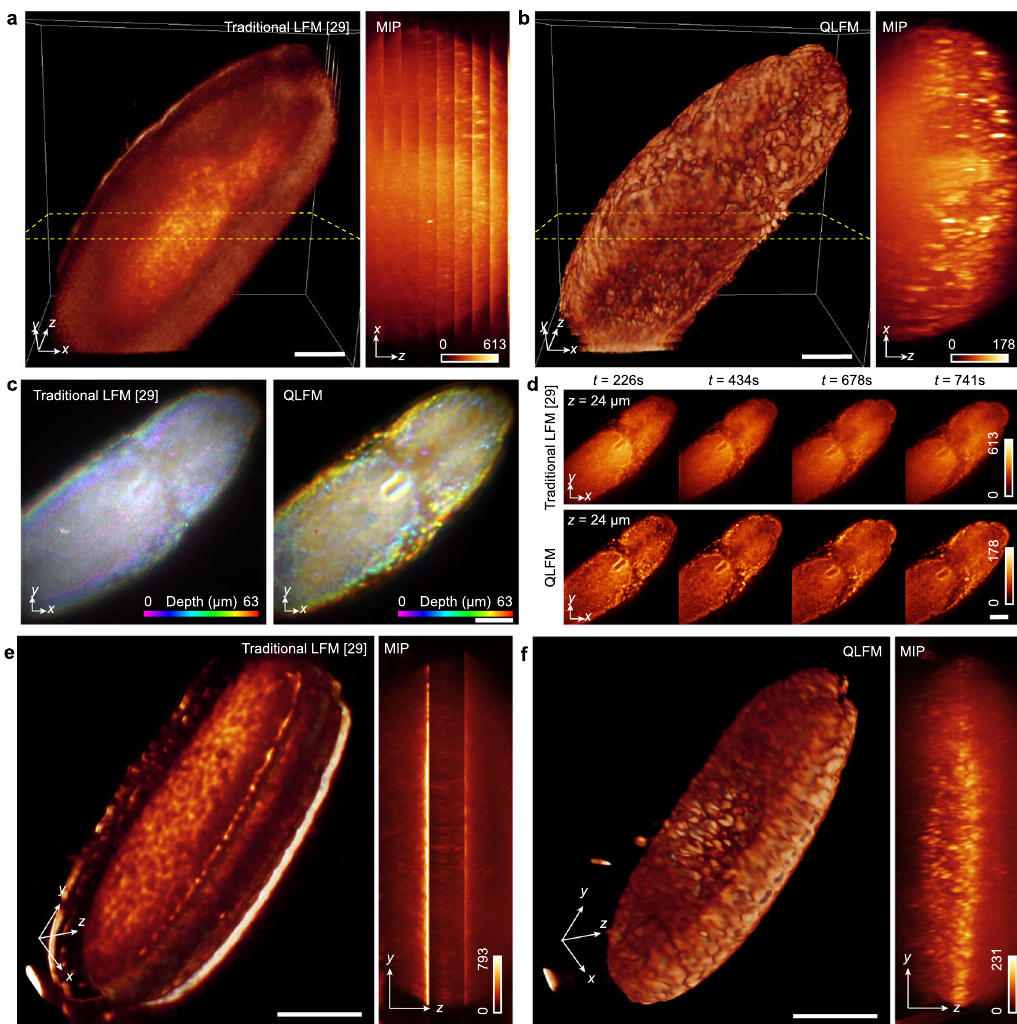
Fig. 3 Experimental comparisons on the histone-labeled Drosophila embryo with high-speed axial scanning. a , b 3D rendered volumes and 180- μ m- xz maximum intensity projections (MIP) at the same time point obtained by traditional LFM and QLFM with a 40×/1.0NA water-immersion objective at an axial step of 15 μ m. QLFM shows much better contrast and resolution than traditional LFM without artifacts, illustrating the capability of computational optical sectioning by QLFM with the improved penetration depth. c Depth-coded MIP of a Drosophila embryo reconstructed by traditional LFM and QLFM. d Slices reconstructed by different methods at various time stamps. e , f The comparisons between traditional LFM and QLFM under a ×20/0.5NA objective in the form of 3D rendered volumes and orthogonal MIPs with axial scanning at a step of 50 μ m, indicating the uniform resolution of QLFM without edge artifacts. The images were processed with Volren modules in Amira 5.4 to get the volume renderings with similar contrast. Scale bars, 50 μ m ( a – d ) and 100 μ m ( e , f